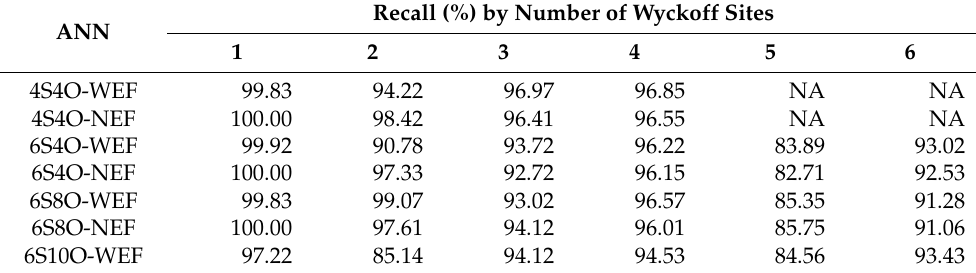
Table 3. Recall with the remaining compounds having structure types different to those depicted in Figure 1 (second